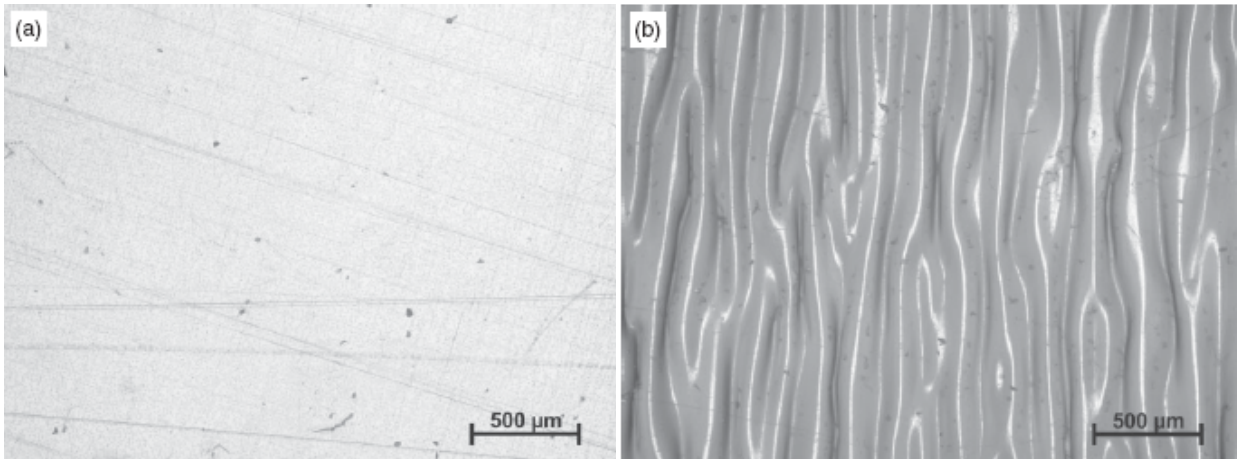
Figure 5. Surface features of an SMP Veriflex TM specimen as observed by optical microscopy. (a) Flat reflecting surface of pristine material with few scratches. (b) Wavy surface features after running 19 thermo-mechanical cycles. Reprinted with permission from [239]. (© 2008, Wiley-VCH Verlag GmbH & Co.